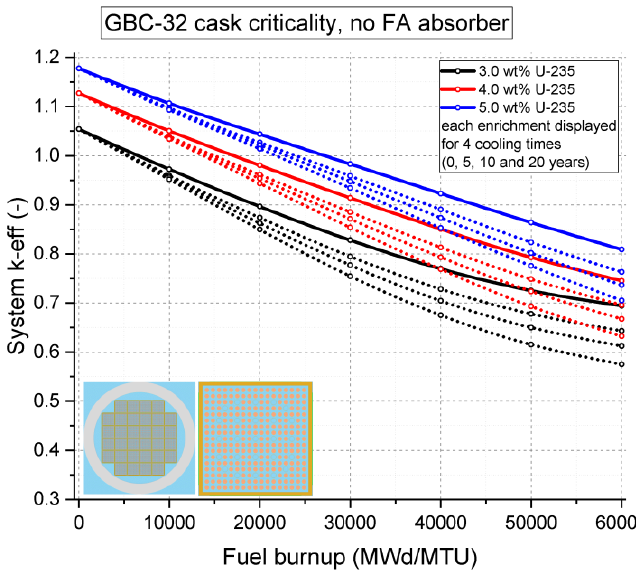
Figure 3. Spent fuel cask criticality without neutron absorber